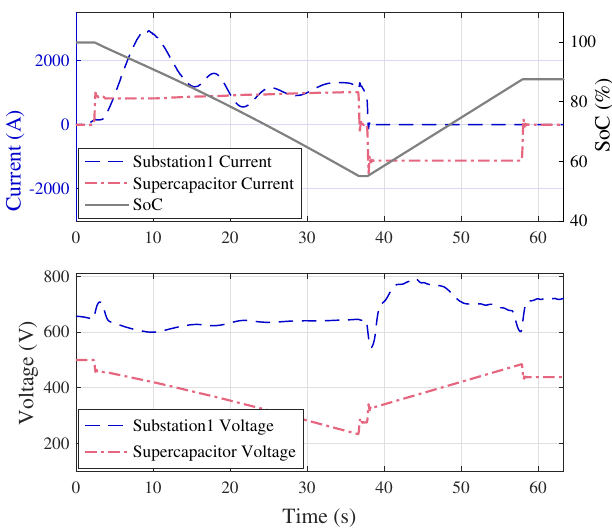
Figure 15. Substation1 and SC Current, SC SoC, Substation1 and SC Voltage for 15% energy saving with standalone SCESS.